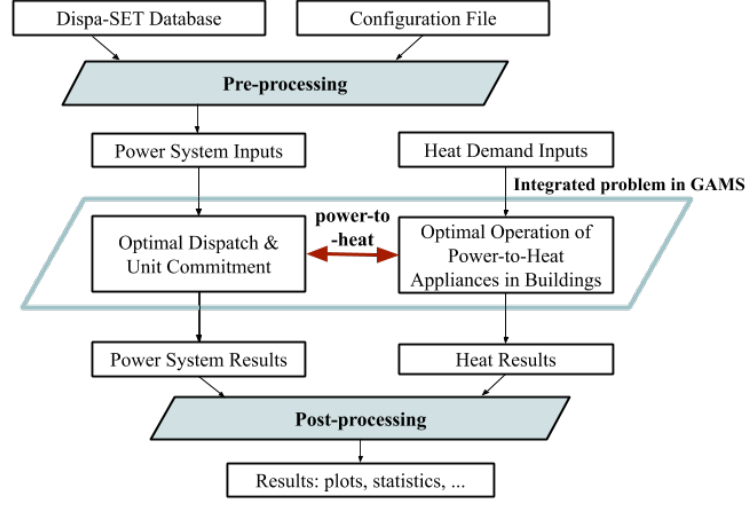
Figure 3. Integrated model flow